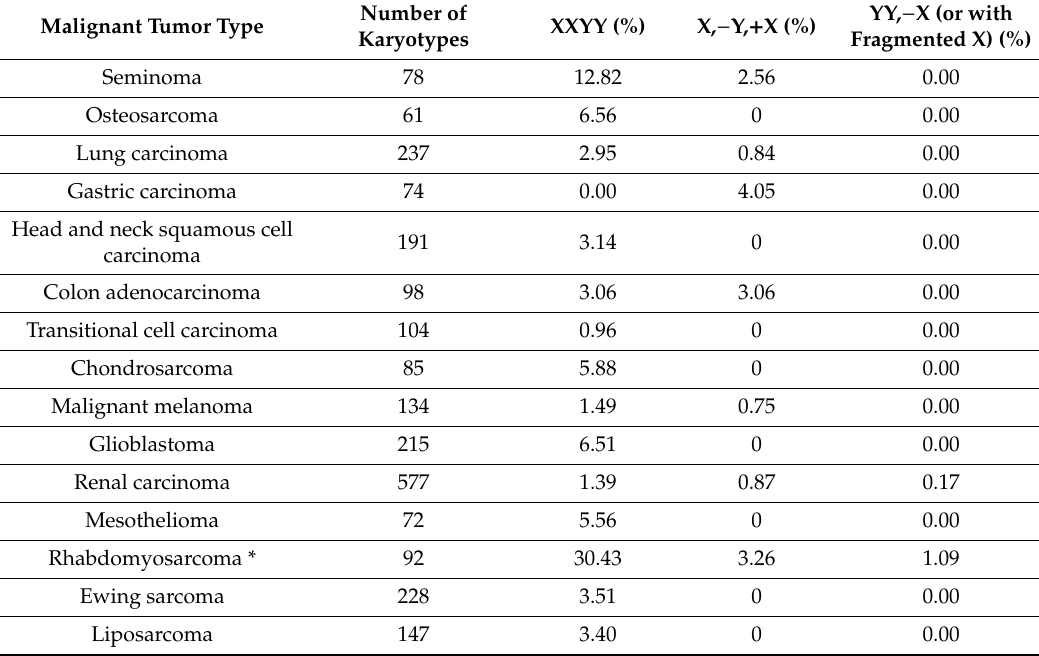
Table 3. The proportions of tetraploid and diploid karyotypes possessing two X chromosomes, and the almost-absent karyotypes with two Y-chromosomes for 15 male malignant tumor cohorts from the Mitelman